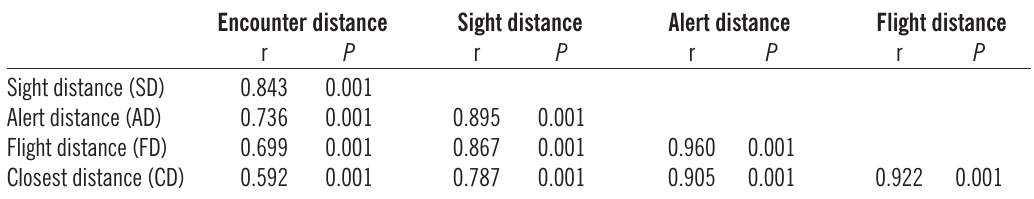
Table 1. Spearman rank correlation for the five dependent variables encounter (END), sight (SD), alert AD), flight (FD) and closest distance (CD).